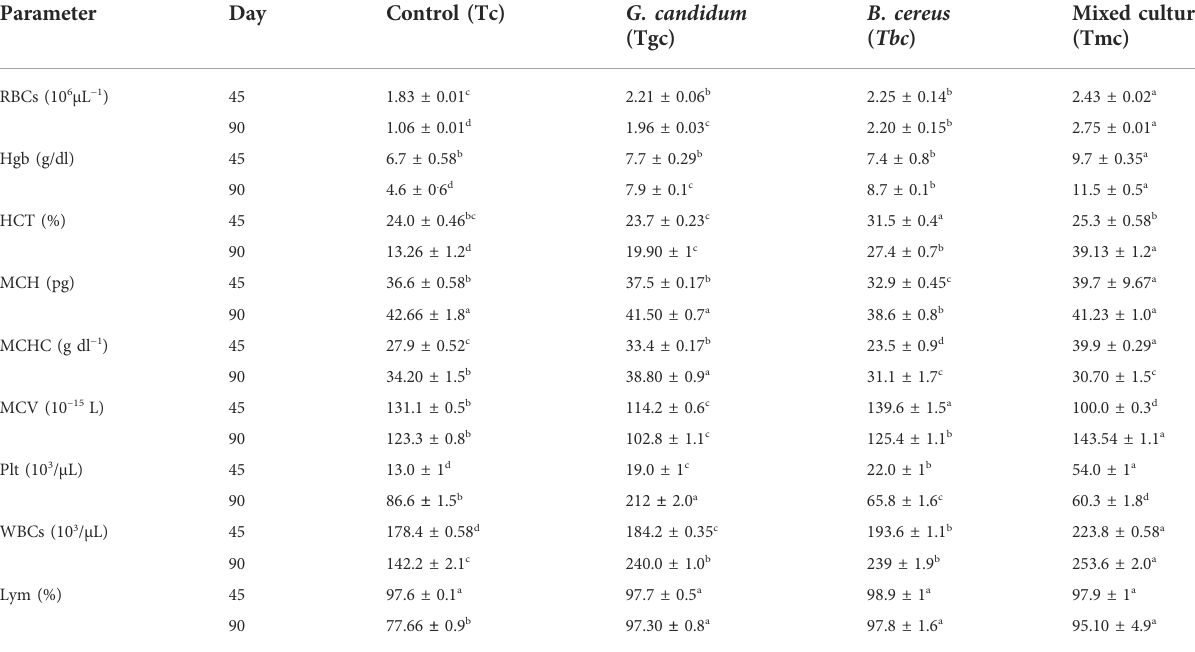
TABLE 4 Impact of feeding probiotic microorganisms (10 9 CFU/gm diet) in single and mixed culture form on hematological parameters of Labeo rohita.